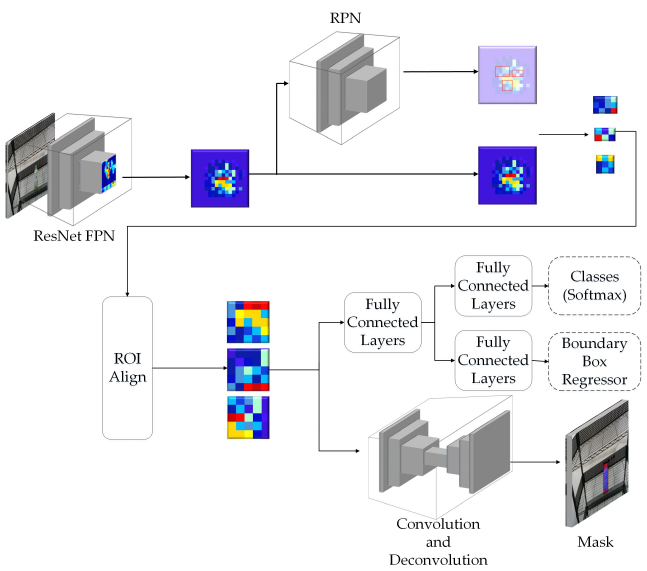
Figure 2. Detailed two-stage structure of Mask R-CNN architecture